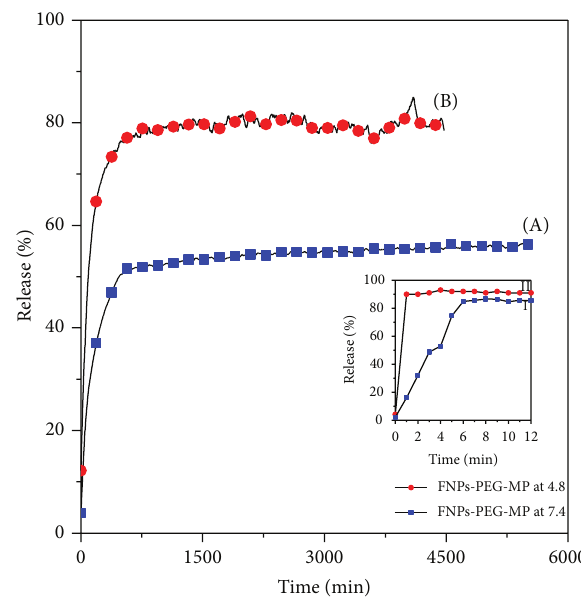
Figure 6: Release profiles of MP from the FPEGMP-2 nanocompos- ite into (A) phosphate buffered solution at pH 7.4 and (B) phosphate buffered solution at pH 4.8. The inset shows the release profiles of MP from its physical mixture of FNPs-PEG-MP into phosphate buffered solution (I) at pH 7.4 and (II) at pH